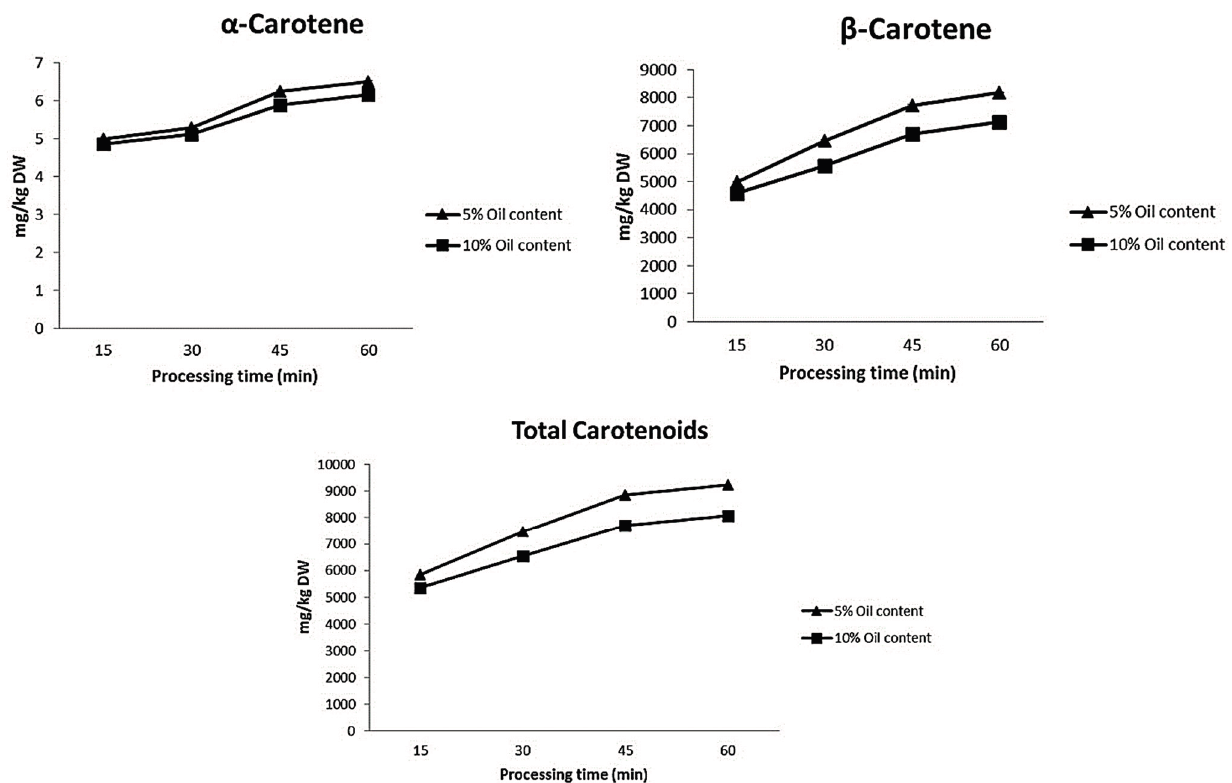
Figure 2. Changes in total carotenoids, α -carotene and β -carotene during processing time. The ( Z )-isomers of lycopene during processing were also studied since these compounds are of particular nutritional benefit due to their ready absorption in the human intestine [20]. We tentatively identified three isomers in tomato sauces: 5-, 9- and 13-( Z )-lycopene (Figure 3). This lycopene isomer profile is in accordance with that reported by other authors in different tomato products, in which ( all-E )-lycopene represents the most abundant lycopene isomer, varying from 35% to 96% of total lycopene, and 5-, 9-, 13- and 15-( Z )-lycopene are the main ( Z )-isomers detected [21,22]. We observed higher levels of ( Z )-lycopene in sauces containing less virgin olive oil. For instance, at 45 min of cooking the concentration of 5-( Z )-lycopene was 79.35 mg/kg DW with 5% olive oil as opposed to 72.06 mg/kg DW with 10% olive